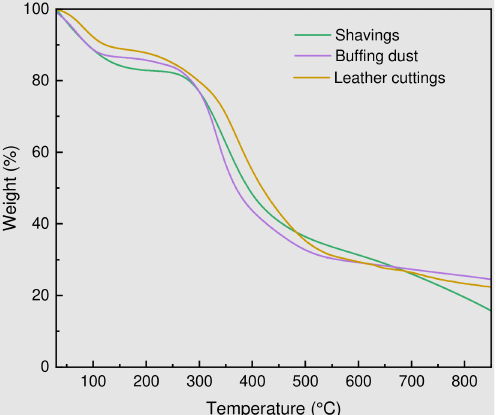
Figure 8. Thermogravimetric analysis of the Cr-containing leather wastes (Adapted from Nur-A- Tomal, et al. [7]. Reproduced with permission from Springer